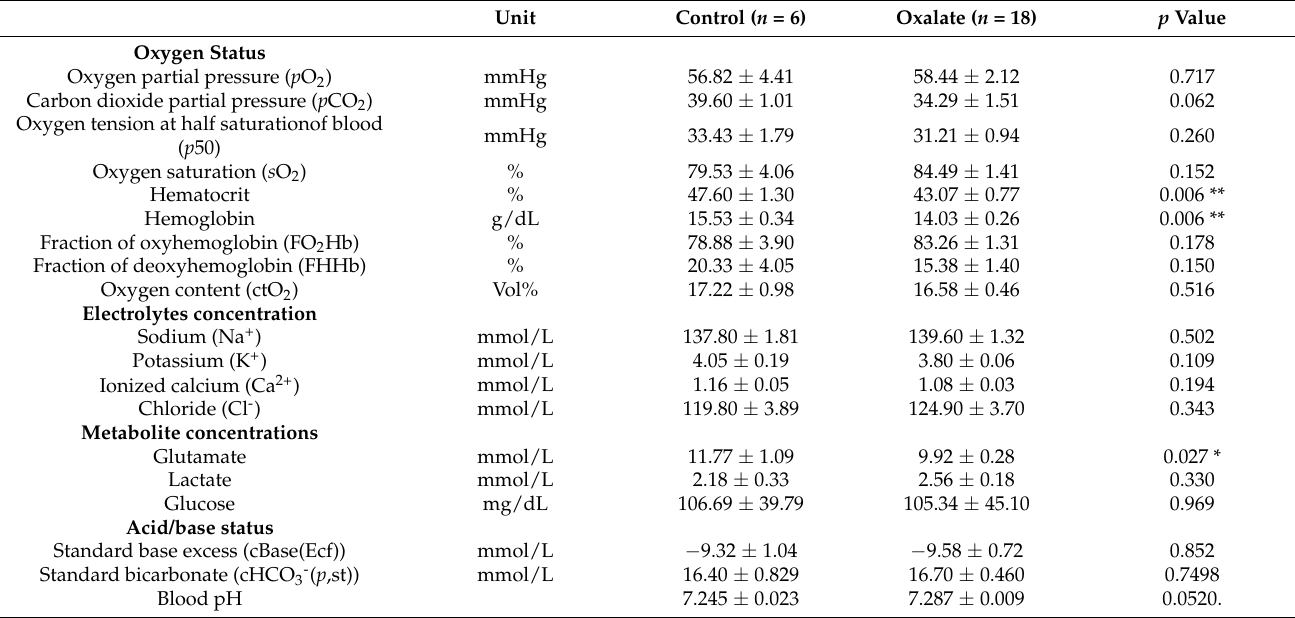
Table 1. Blood parameter analysis after 3 weeks of the OXA diet (results are expressed as mean ± SD. Control n = 6, oxalate n = 18).